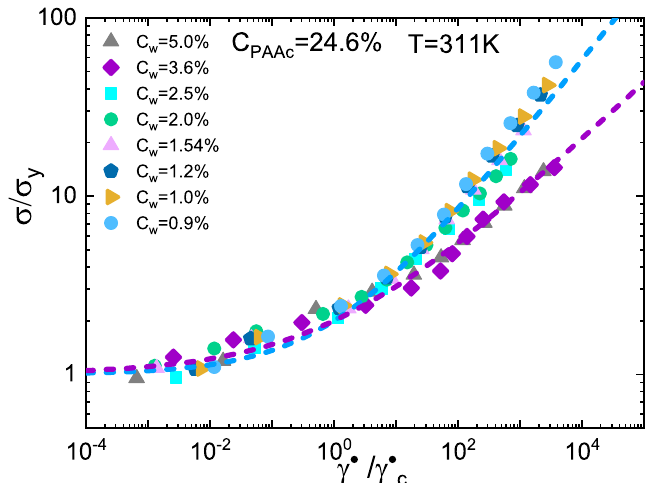
Figure 6. Scaled plot of normalized shear stress against reduced shear stress for IPN microgels at C PAAc = 24.6%, T = 311K and at different weight concentrations. All data follow two mastercurves indicating the existence of glass and jammed states. Lines are fits to data according to Equation